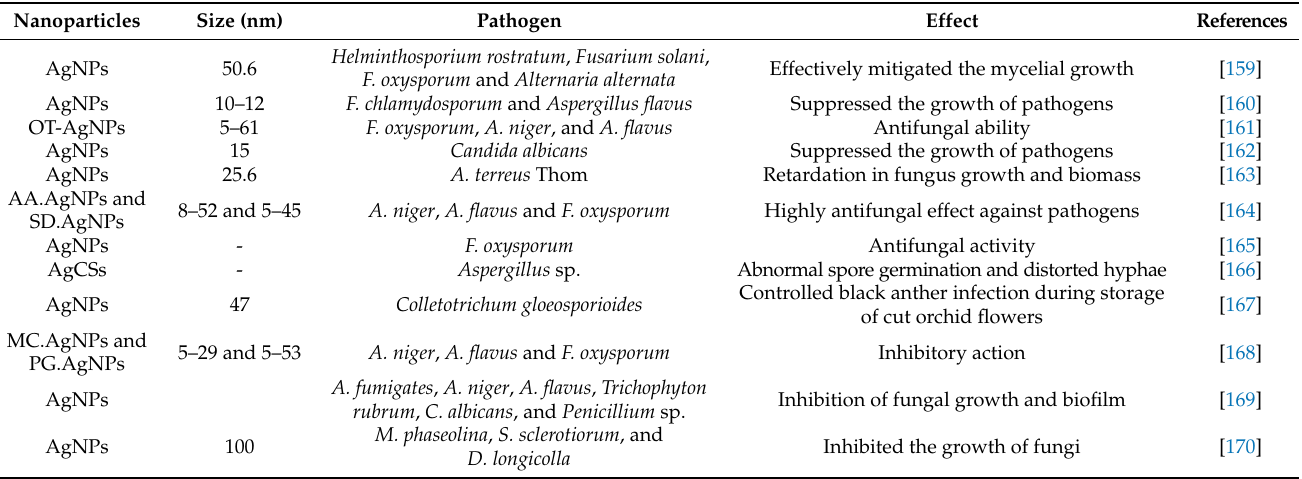
Table 6. AgNPs in fungal disease